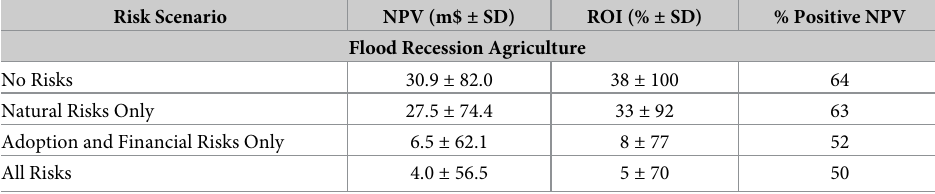
Table 5. NPV, ROI and probability of positive